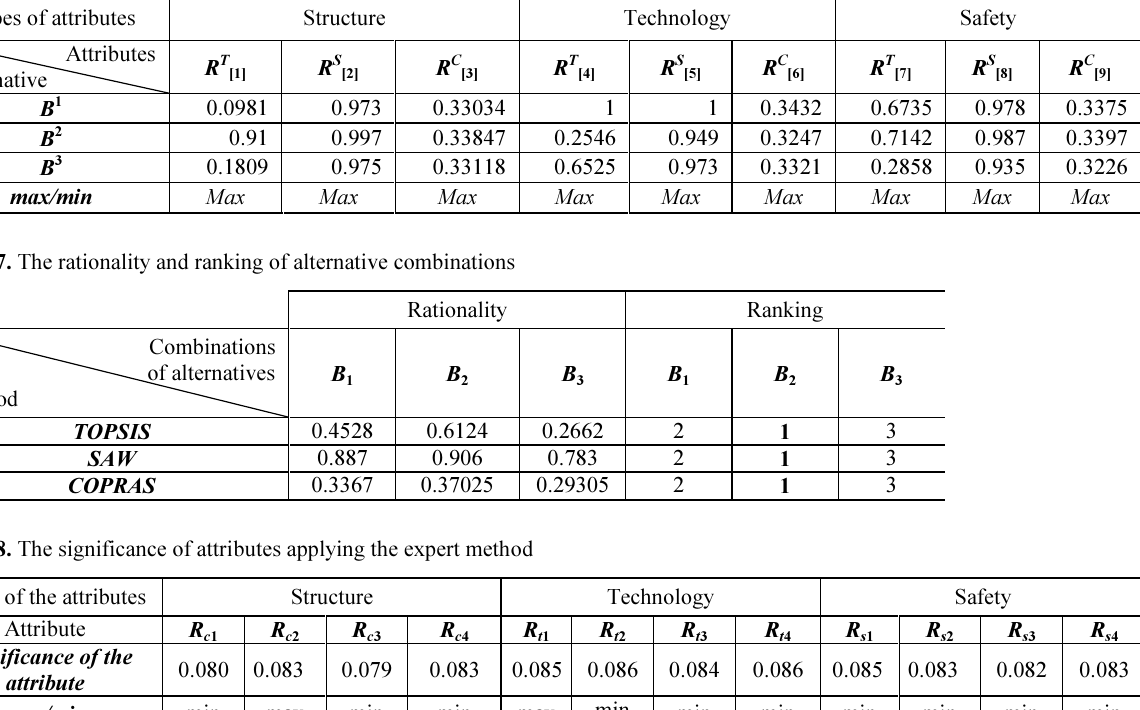
Table 6. A dataset of alternative combinations Types of attributes Structure Technology Attributes